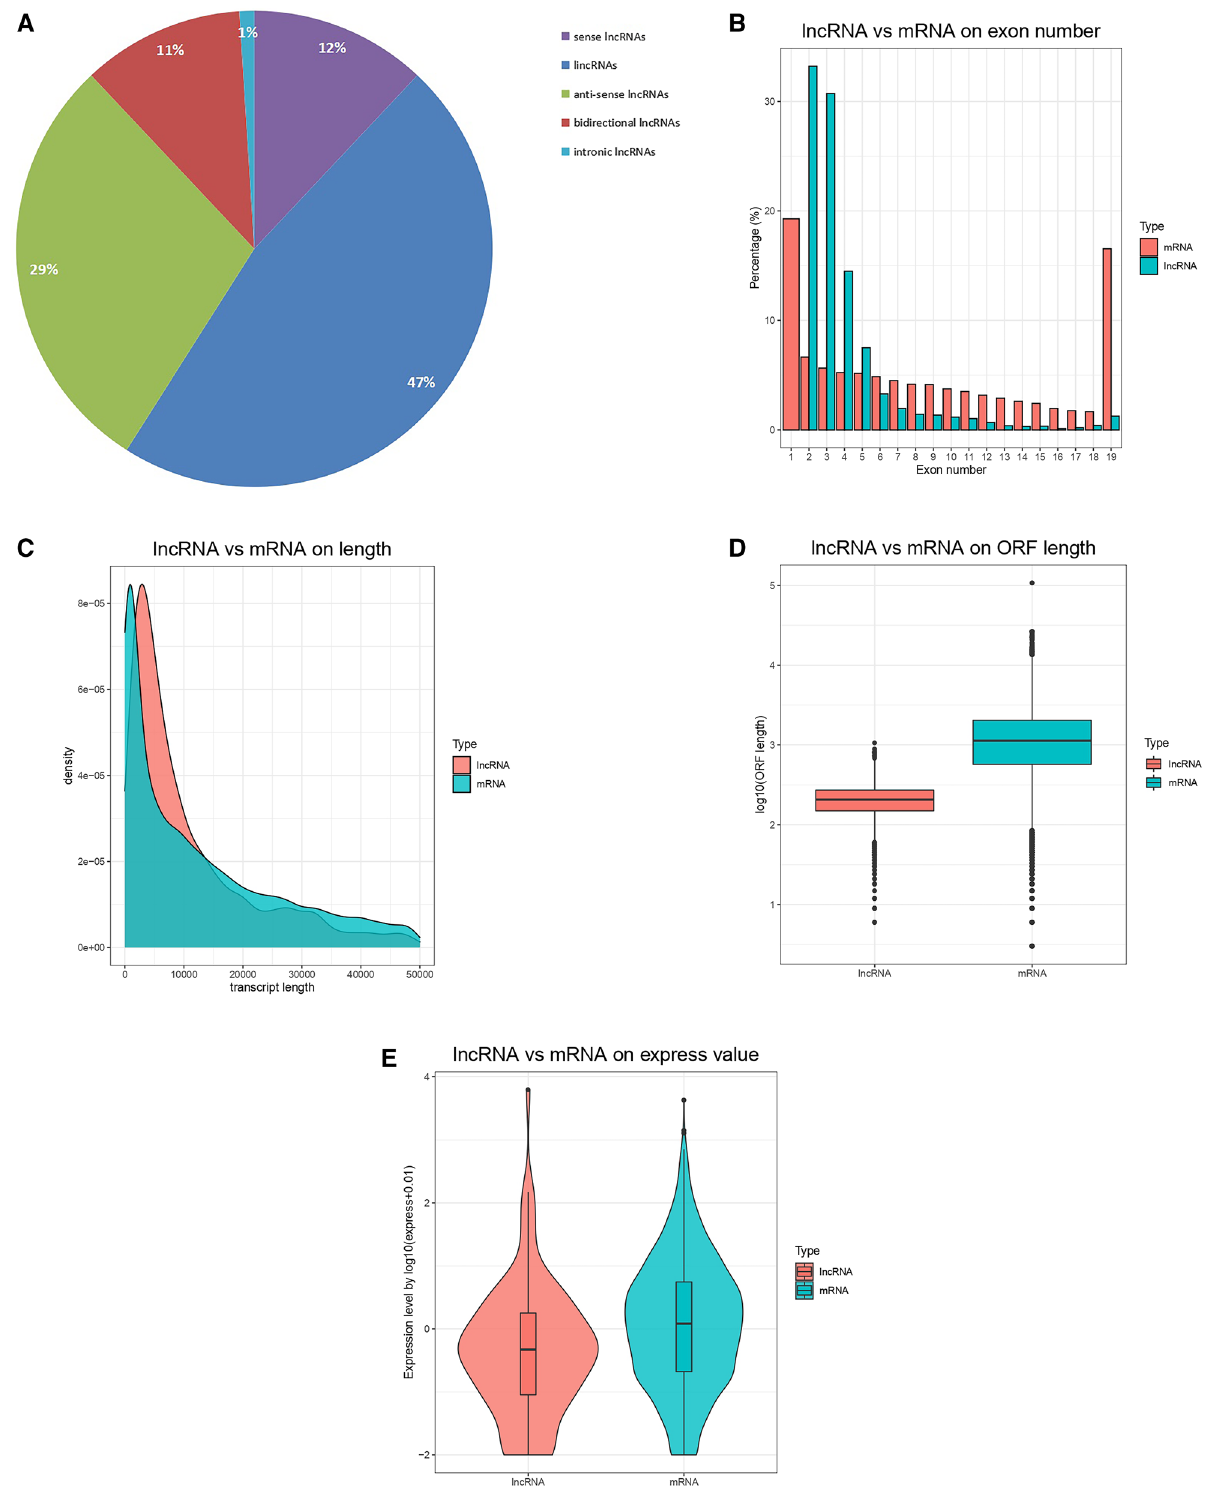
Figure 1. LncRNA characterization and gene expression. ( A ) Summary of lncRNA types. ( B ) Number distribution of lncRNA and mRNA exons. ( C ) LncRNA and mRNA length distribution. ( D ) LncRNA and mRNA ORF length. ( E ) Expression levels of lncRNA and